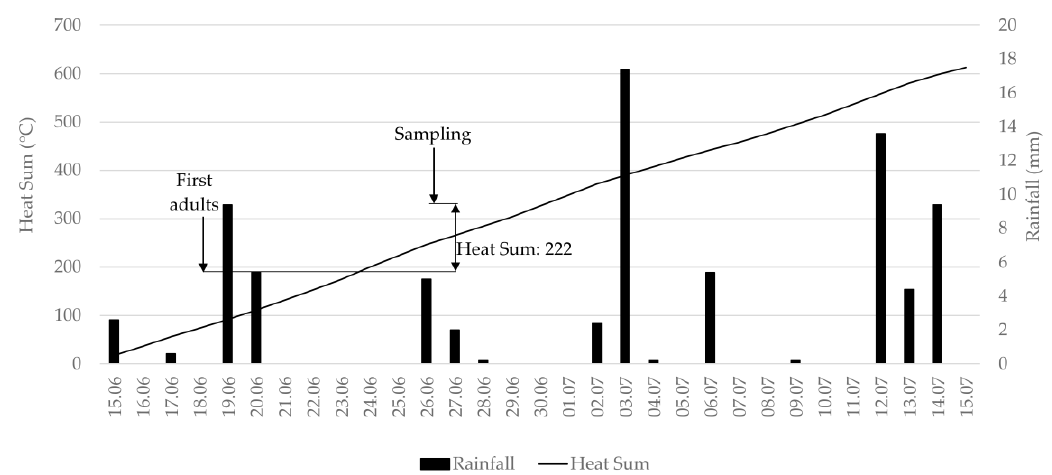
Figure 2. Cumulated effective temperature for the development of Thrips tabaci and precipitation recorded in 2016.